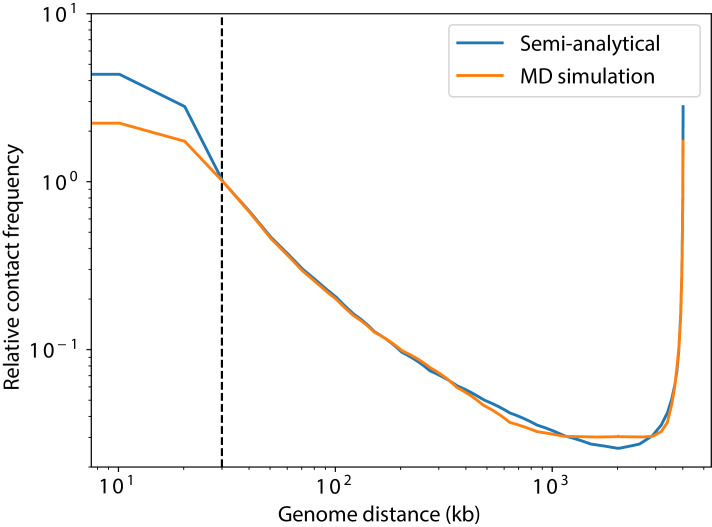
Contact probability as a function of genomic distance generated from molecular dynamics simulations as compared to the semi-analytical method.Data from molecular dynamics (MD) simulations is shown in orange, while the contact probability calculated from the semi-analytical method is shown in blue.